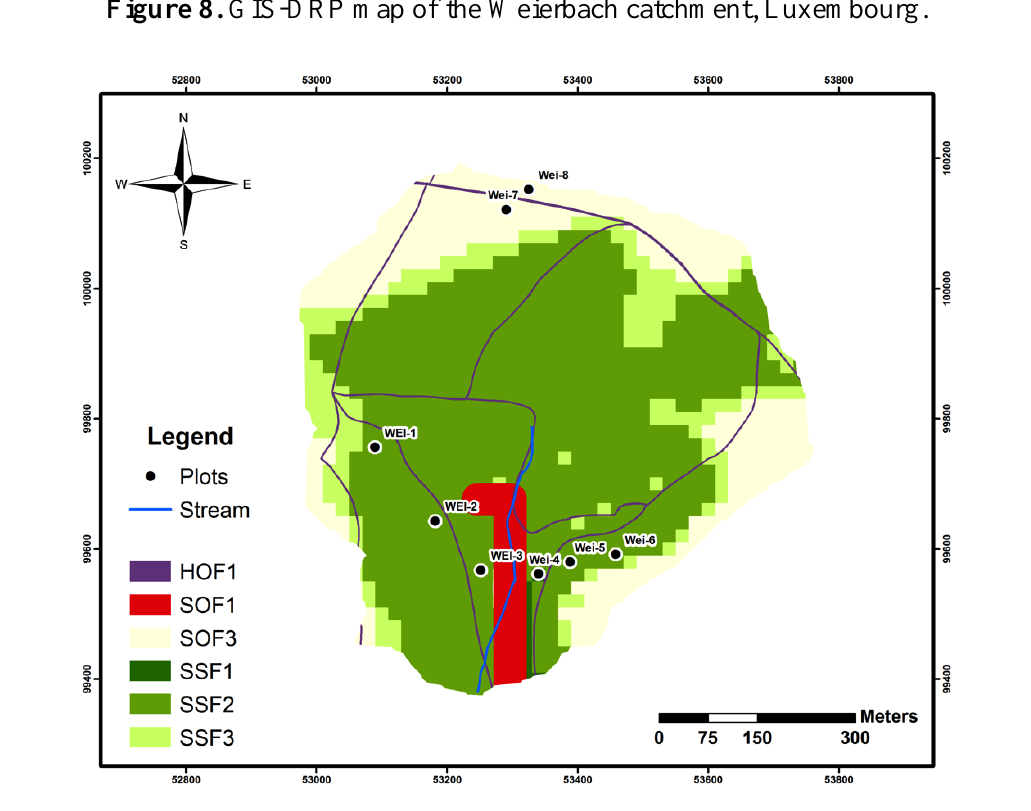
Figure 8. GIS-DRP map of the Weierbach catchment,